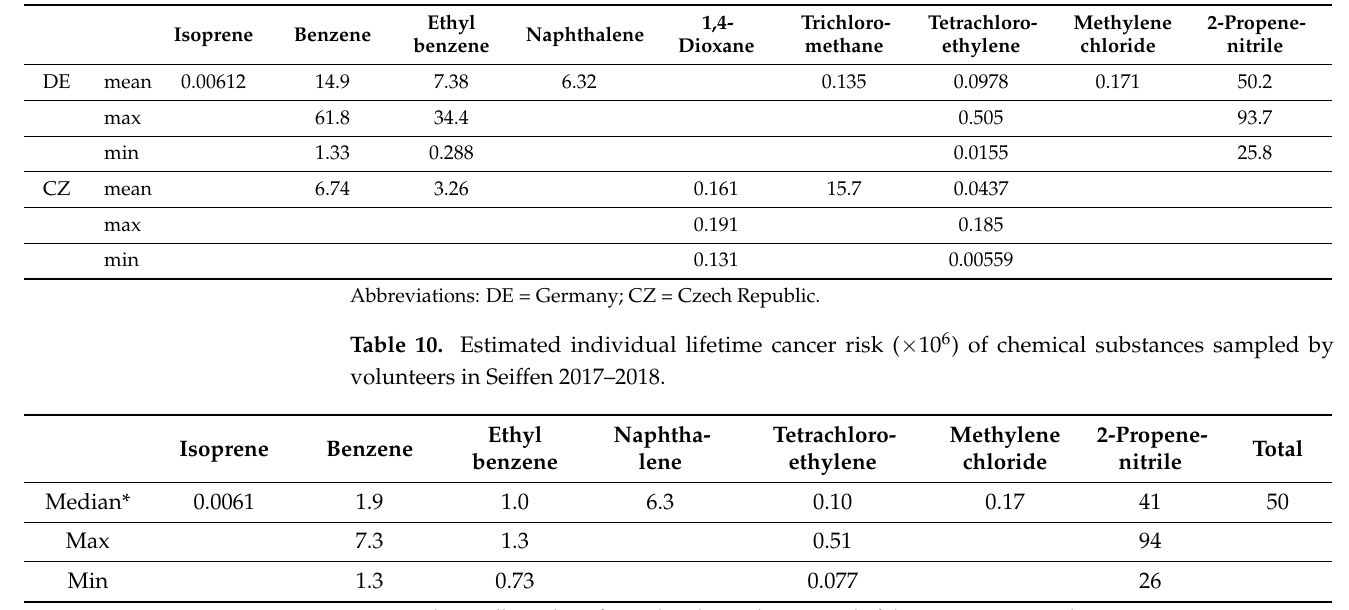
Table 9. Estimated individual lifetime cancer risk ( × 10 6 ) from exposure to carcinogenic compounds during the odor episodes near the Czech–Saxon border.